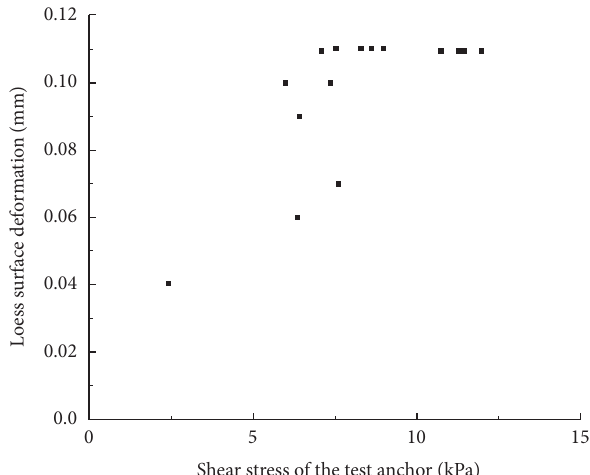
Figure 10: Changing trend between loess surface deformation and shear stress of the test anchor (the 3rd).